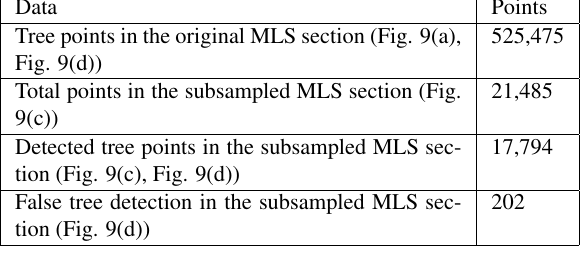
Table 2: Tree classification performances on a small section of the MLS point